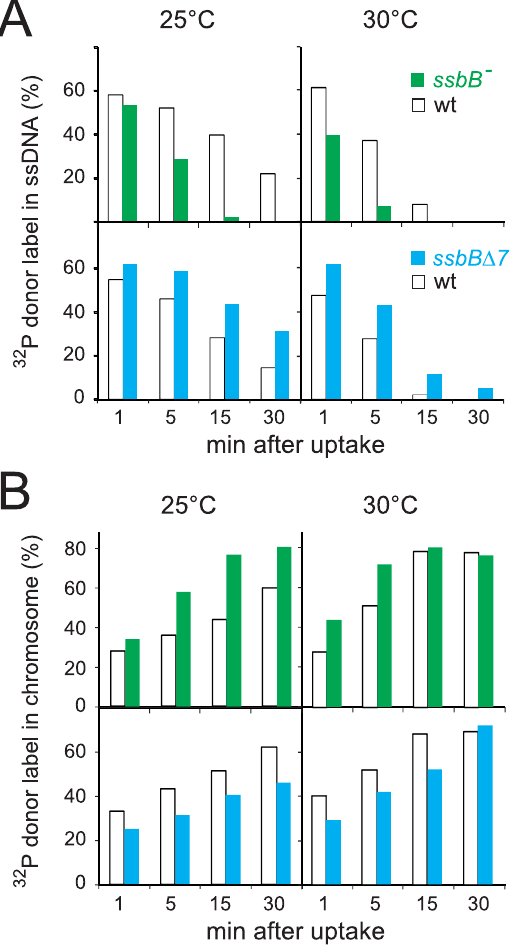
Figure 2. Fate of internalized ssDNA at 25 6 C and 30 6 C in wildtype and ssbB mutant cells. (A) Kinetics of decay of internalized ssDNA. To investigate the impact of ssbB mutations on the stability of internalized ssDNA, pairwise comparison experiments involving an ssbB mutant ( ssbB 2 , R2201; or ssbB D 7 , R2204) and its wildtype parent (R1521) were conducted. Competent wildtype and ssbB mutant cells were transformed for 3 min with a 7771-bp S. pneumoniae fragment uniformly labeled with 32 P, then incubated for 1, 5, 15 or 30 min; total DNA was extracted and the fate of transforming DNA was analyzed through agarose gel electrophoresis (Materials and Methods; Figure S2). The amount of ssDNA was calculated using densitometer tracings of electrophoregrams corresponding to extracts of cells transformed at 25 u C (Figure S2, panels A and C; for an example, see blue rectangle in panel A), or in parallel at 30 u C, and expressed relative to total donor DNA uptake in each extract; total uptake value for each time point was normalized to the average uptake value at 25 u C (Figure S2B and S2D) or 30 u C. (B) Kinetics of incorporation/integration of 32 P donor label in the chromosome. Similarly to the measurement of ssDNA label described above, the amount of donor label incorporated/integrated into the chromosome was calculated from densitometer tracings of electro- phoregrams, through integration of counts in the area corresponding to chromosomal DNA (for an example, see red rectangle in Figure S2A). Same symbols as in panel A.